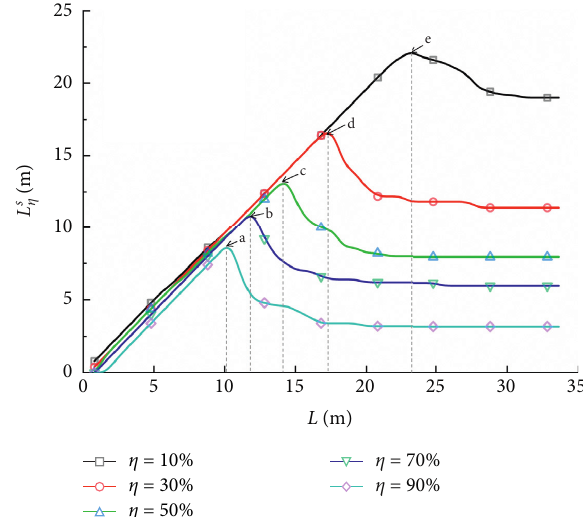
Figure 4: L s at different slot η